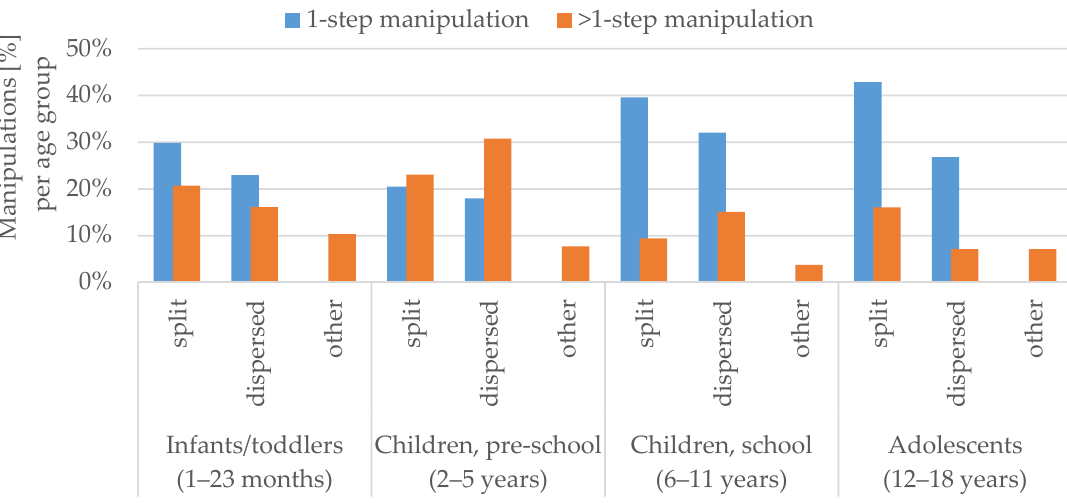
Figure 4. Main type of manipulation per age group (%) based on the total number of manipulations per age group classified by the number of manipulation steps (one or more than one ‐ step).